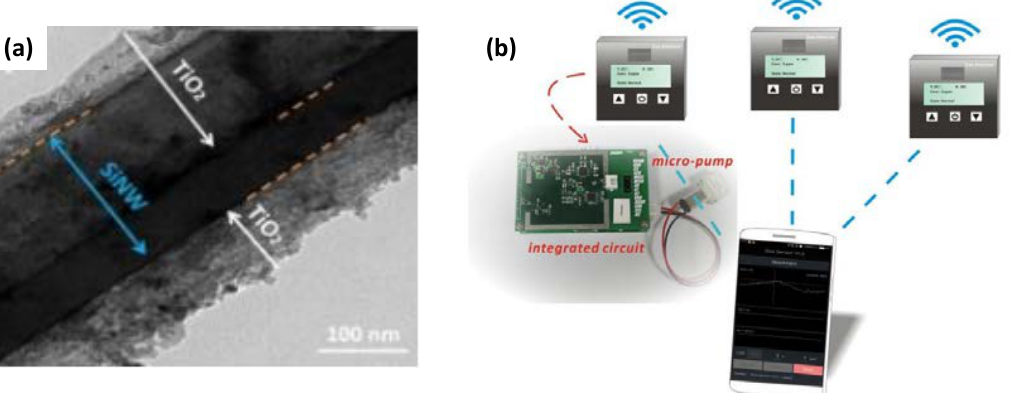
Figure 15. ( a ) TEM image of Si nanowires after being coated with TiO 2 . ( b ) The gas-sensor network linked by a mobile phone fitted with Andriod software, the integrated circuit, and the sensing trace depicted on cell phone figure are real pictures of products, “Reprinted/adapted with permis- sion from Ref. [138]. 2017, Liu, D. et al.”.